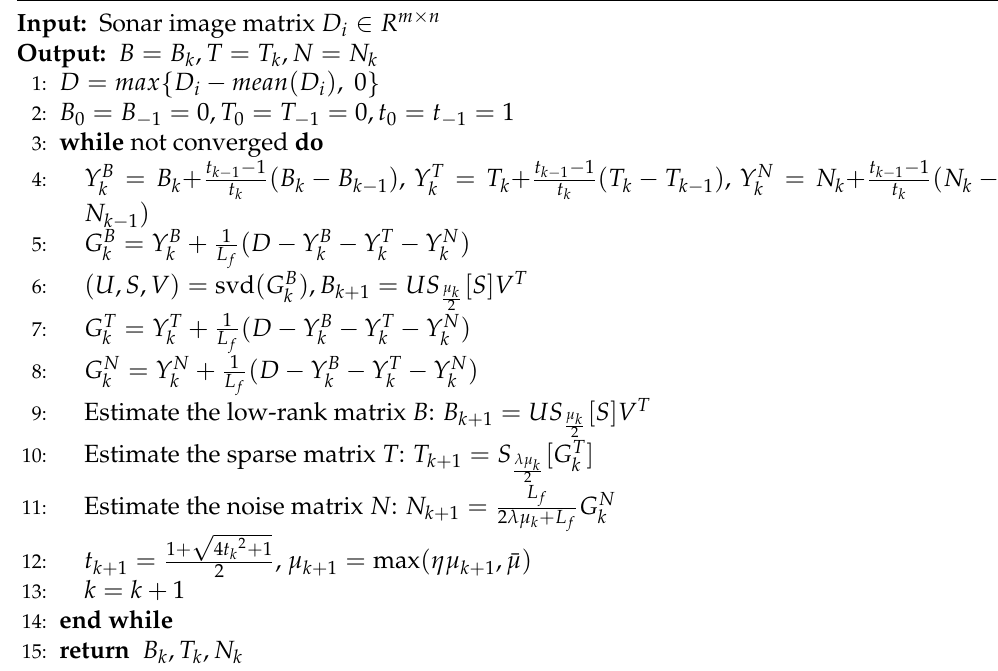
Algorithm 1 Low-Rank and Sparsity and Noise Matrix